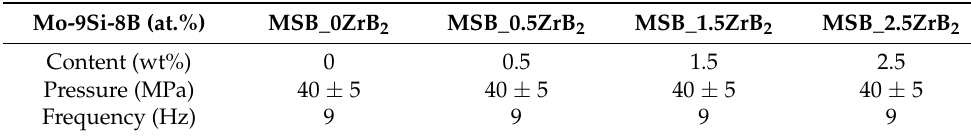
Table 1. Investigated alloys with different additions. Mo-9Si-8B